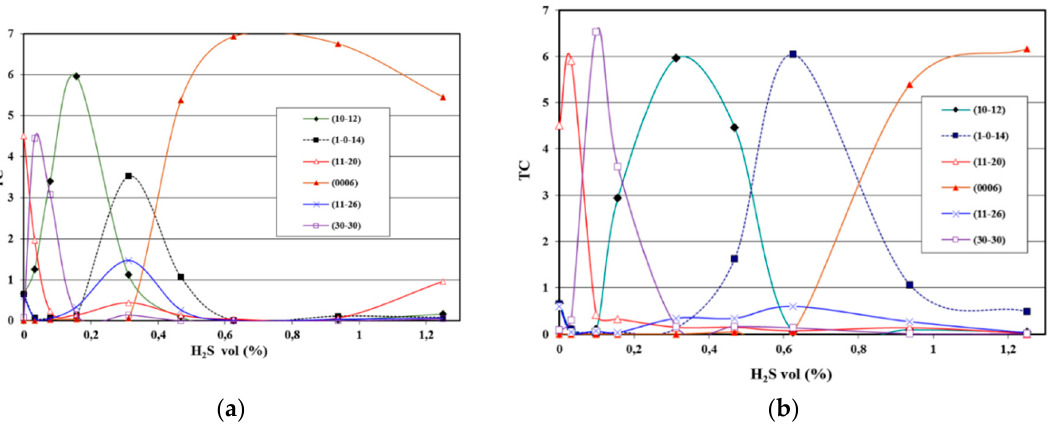
_ _ _ _ _ _ 2), (11 2 0), (10 1 4), (0006), (11 2 3), (11 2 6) and (30 3 0) in CVD α - = 3.25 vol % ( b ) CO = 6.25 vol 2